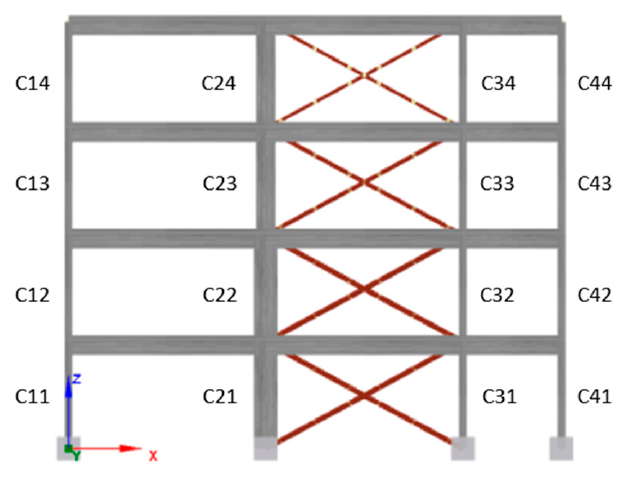
Figure 4. Layout of the proposed retrofitting system.